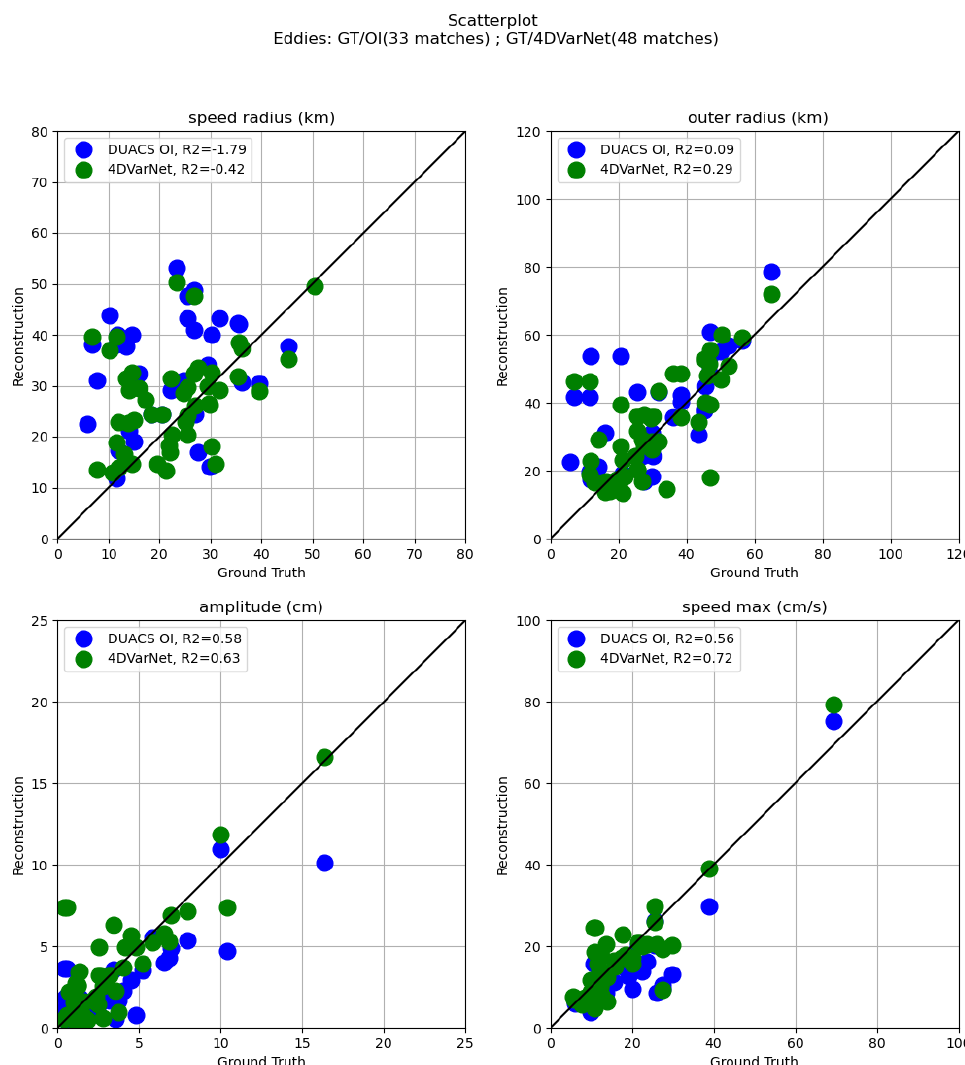
Figure C4. Speed radius (km), outer radius (km), amplitude (cm), and speed max (cms − 1 ) scatterplots of 4DVarNet/DUACS OI (four nadirs) vs. ground truth on the OSMOSIS domain (25 October 2012) for matching